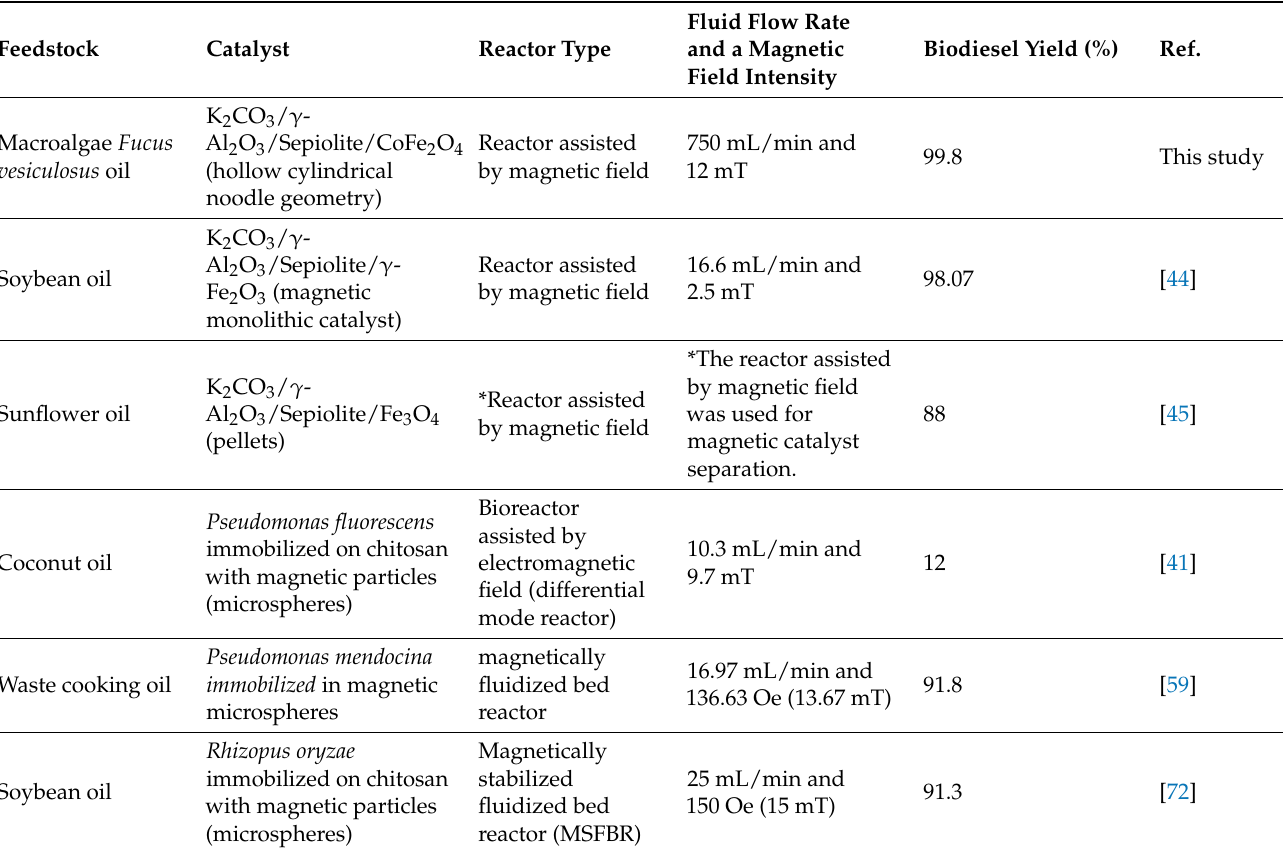
Table 3. Biodiesel production from several feedstocks in reactors assisted by magnetic field.